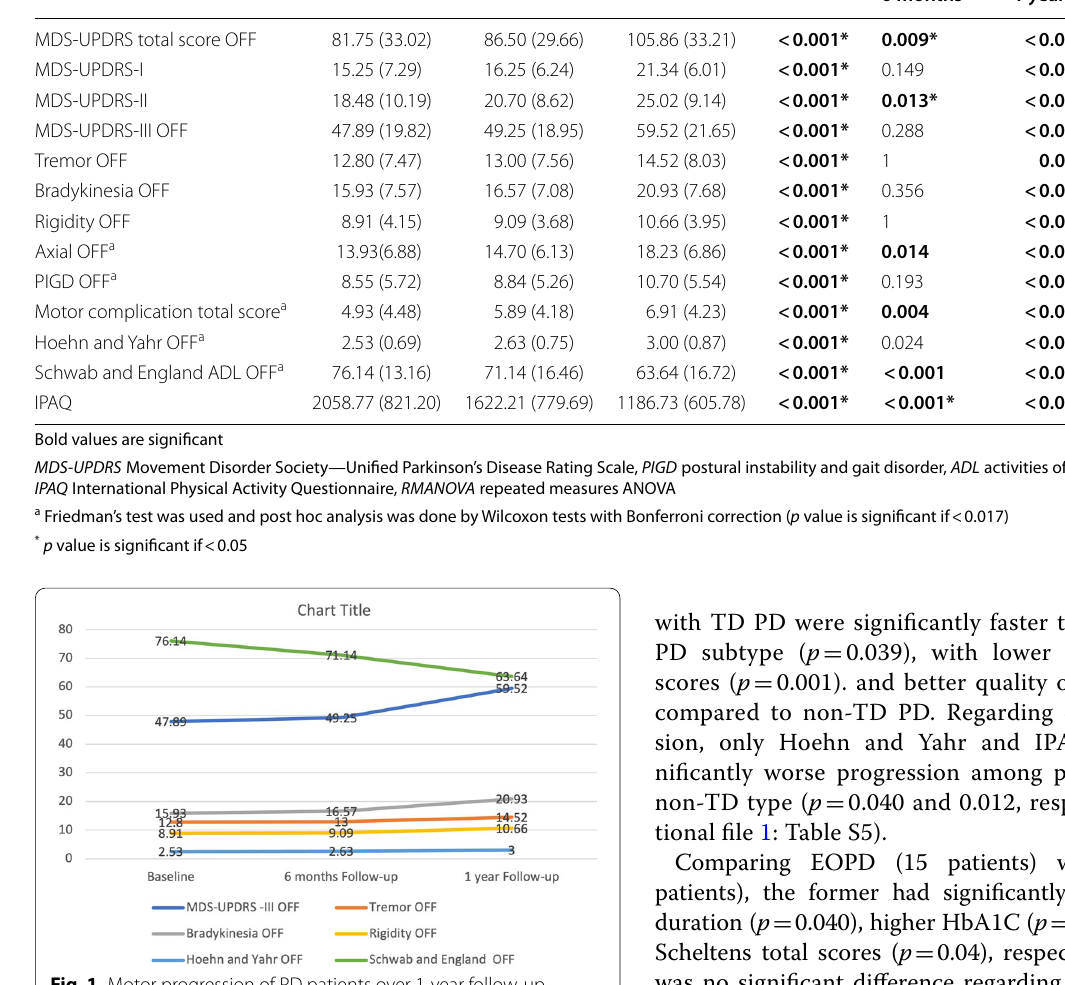
Table 2 Progression of motor and physical activity over 6‑month and 1‑year follow‑up